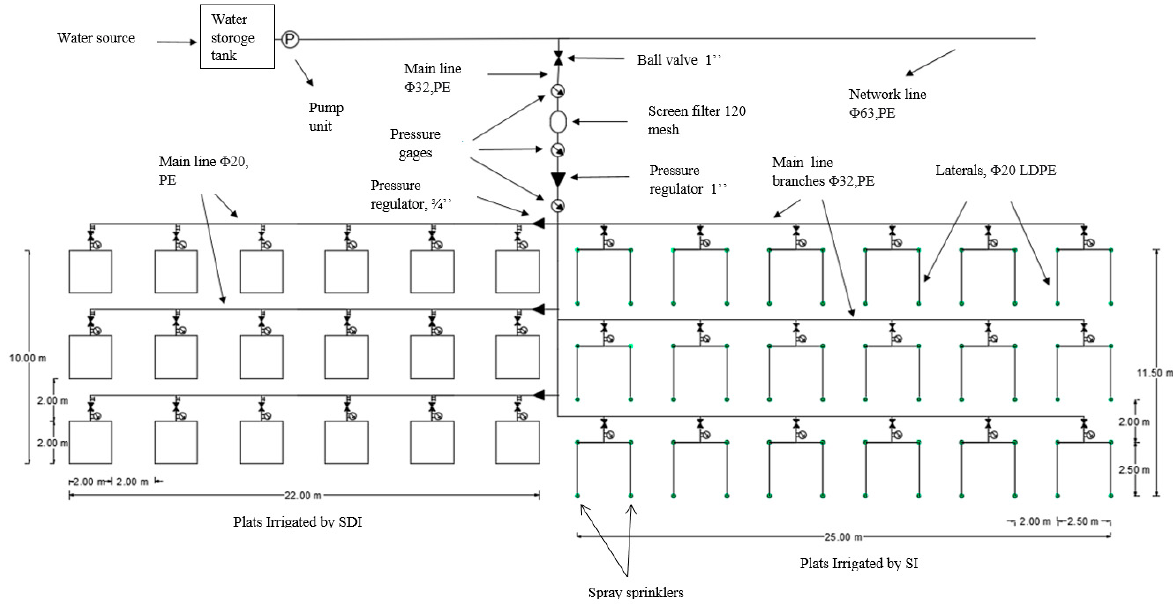
Figure 1. Experimental plots design.